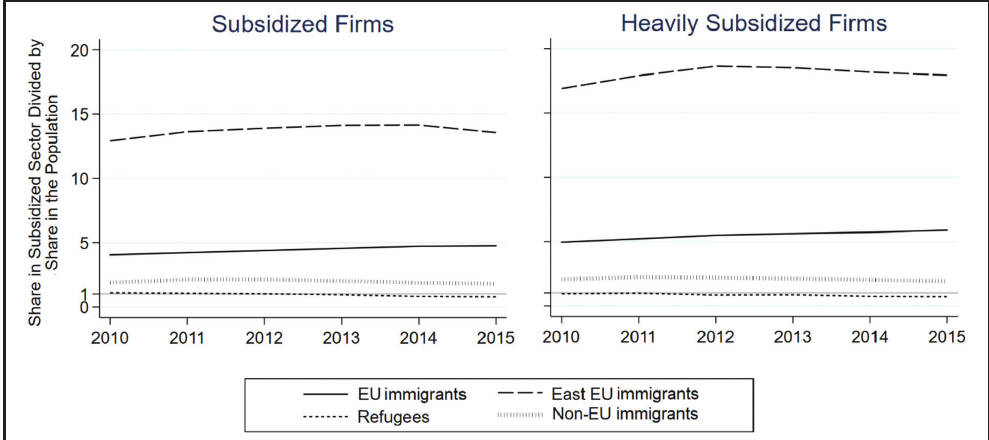
Ratios of employment shares to population shares for immigrant